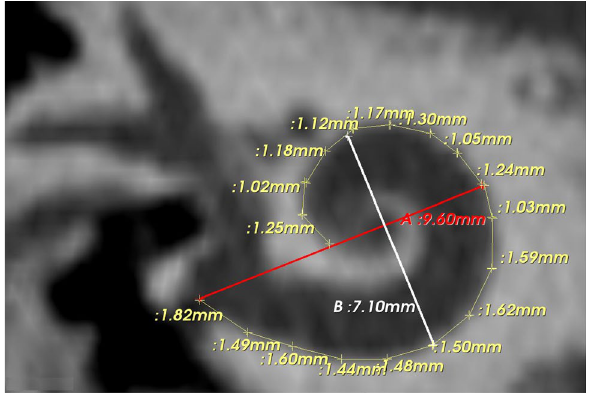
Figure 1. Oblique coronal view/cochlear view showing the A- (red line), and B- (white line) values and the lateral wall length